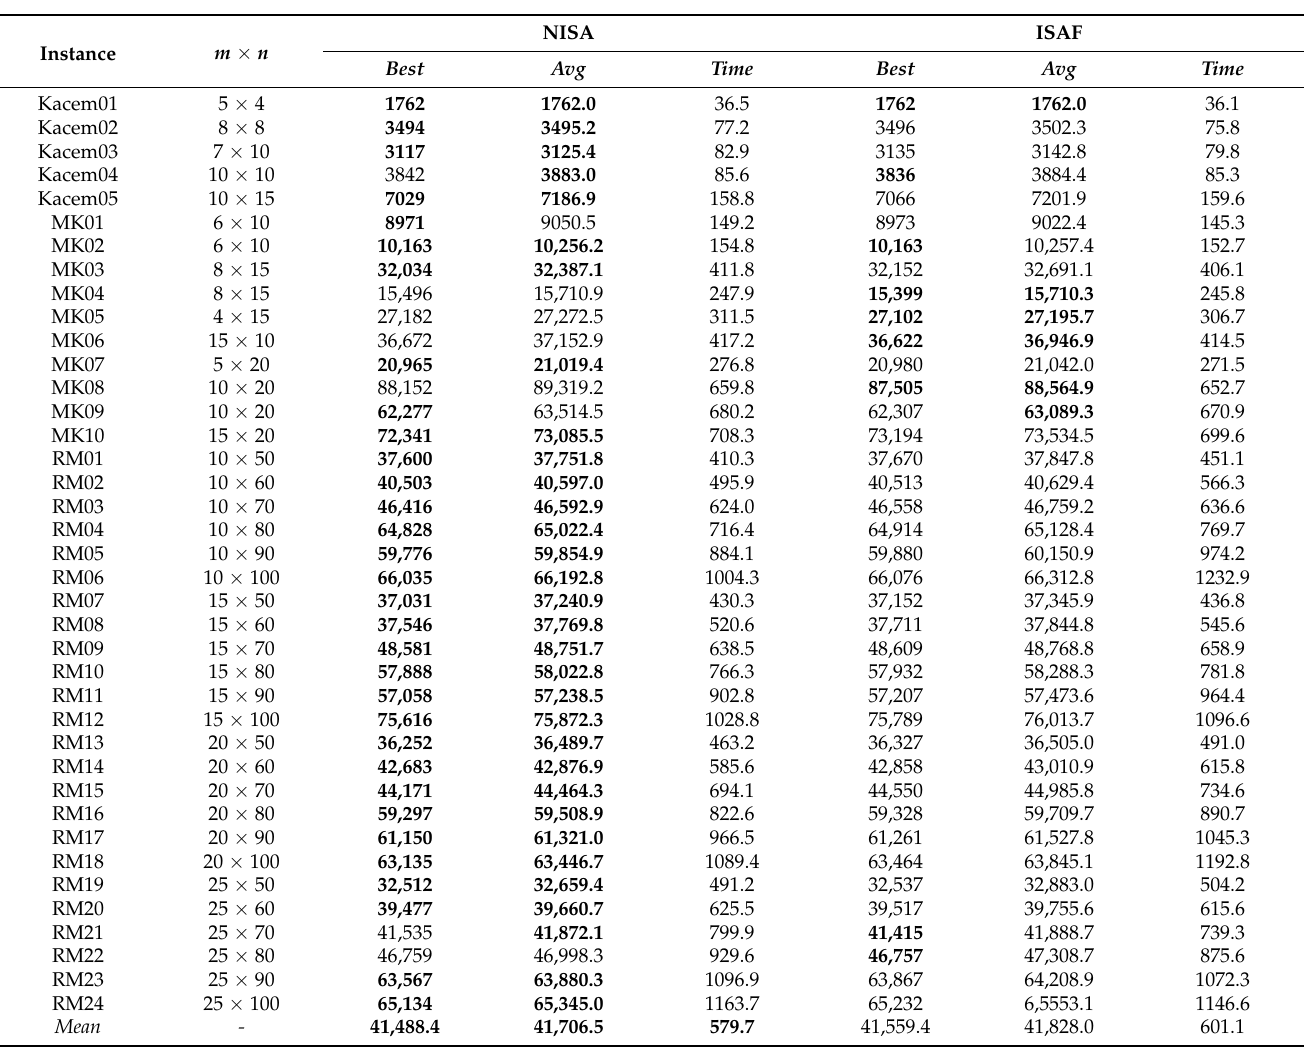
Figure 6. The curves of BRPD and ARPD in the comparison between NISA and ISAF. Table 6. Effectiveness analysis of the dynamic adjustment on α .